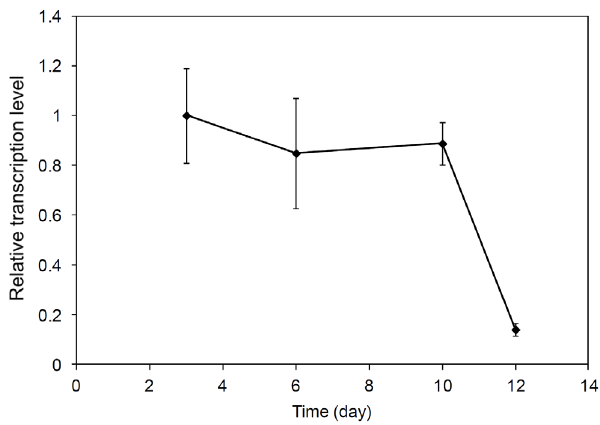
Figure 4. Transcript of hydB (Suden_1435) in S. denitrificans DSM-1251. S. denitrificans DSM-1251 cells were grown in DSMZ medium 113 with thiosulfate (18.8 mM) and H 2 /CO 2 (80%/20%) in the headspace. The relative transcription levels of hydB were quantified by RT-qPCR and normalized to the reference gene rpoD (housekeeping sigma factor). The transcription level of hydB after 3 days was set as 1. Error bars denote standard deviations from three independent